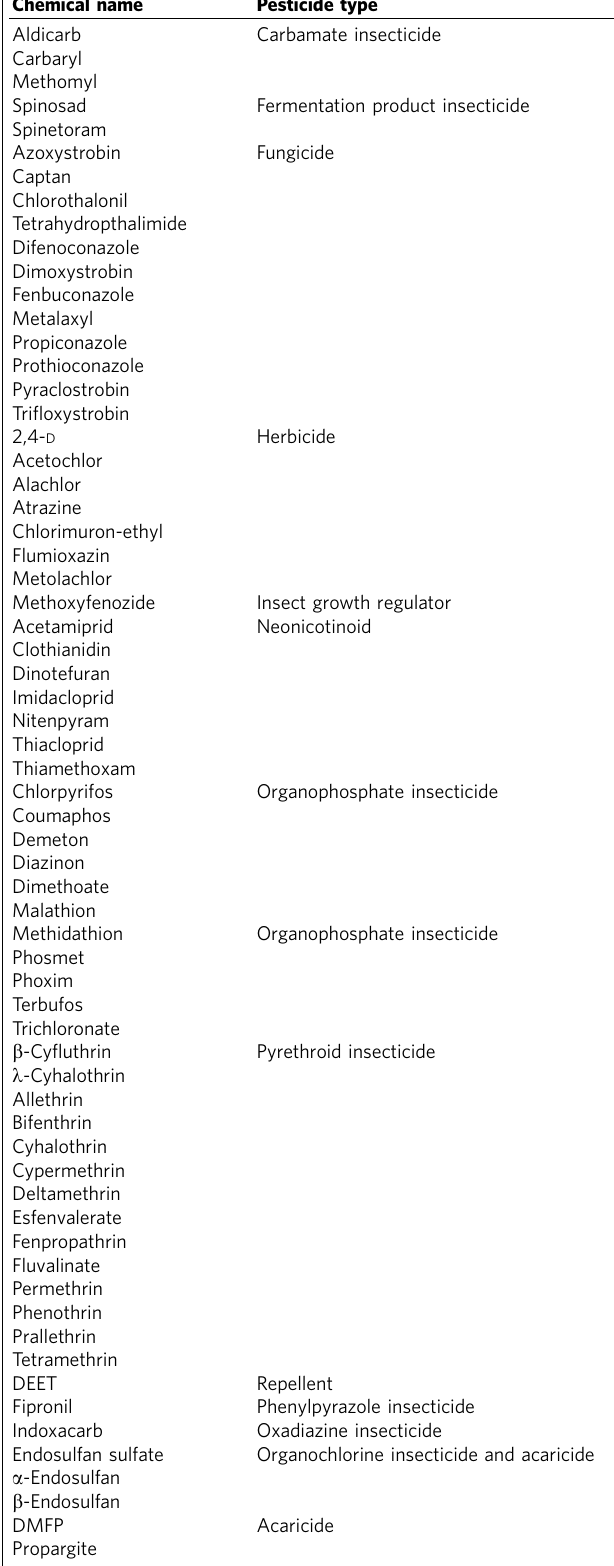
Table 6 | Proportional land use types in a 2 kilometer radius surrounding the locations where honey bee colonies were placed in 2011.